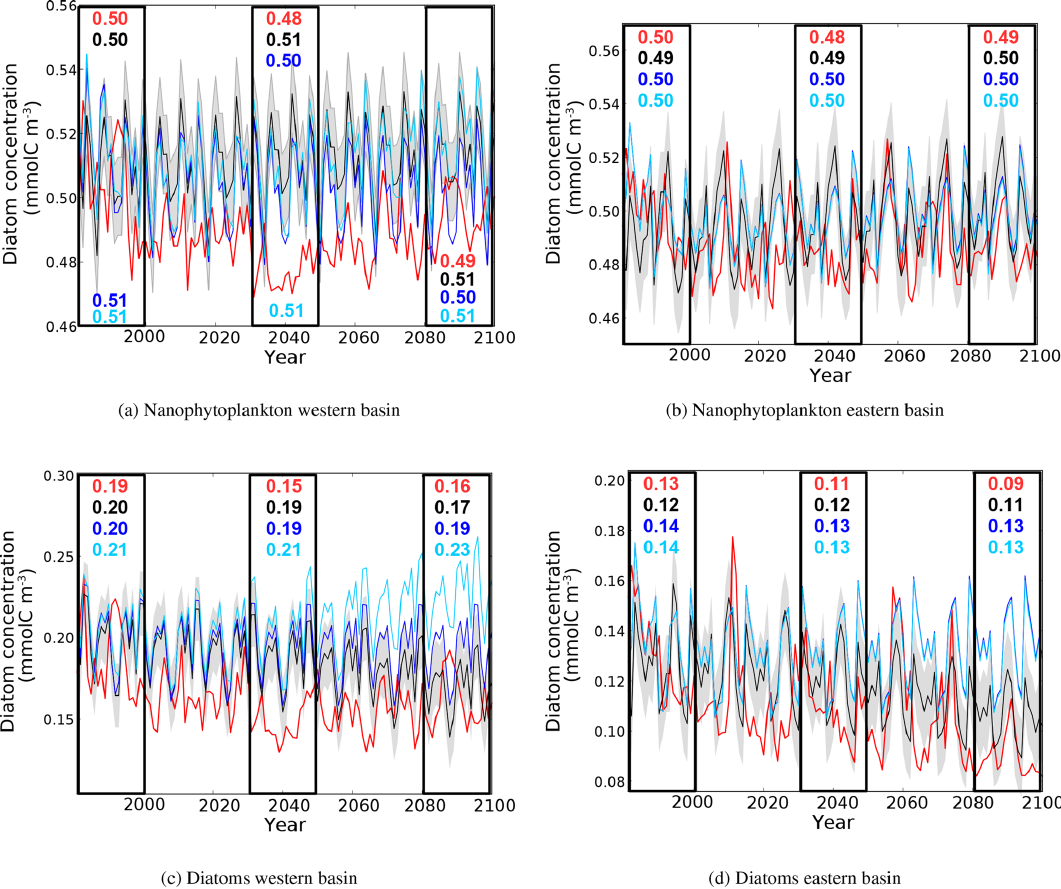
Figure 15. Evolution of yearly average nanophytoplankton and diatom concentration (10 − 3 molm − 3 ) in the surface layer of the western and eastern basin. The red line represent the HIS/A2 simulation, the black lines represent the CTRL simulation (with standard deviation), and blue and light blue lines represent the CTRL_R and CTRL_RG simulations respectively. Colored numbers in the highlighted areas represent the average concentrations in the corresponding simulations for the highlighted time